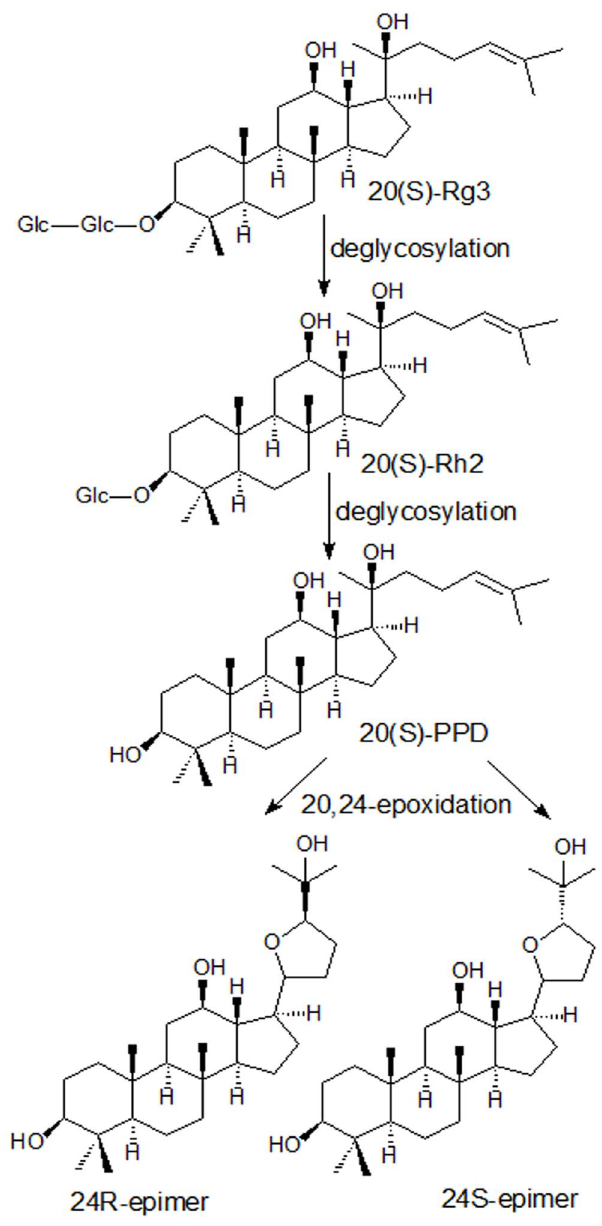
Figure 1. Proposed possible metabolism pathway of ginseno- side Rg3 and its deglycosylated metabolites.